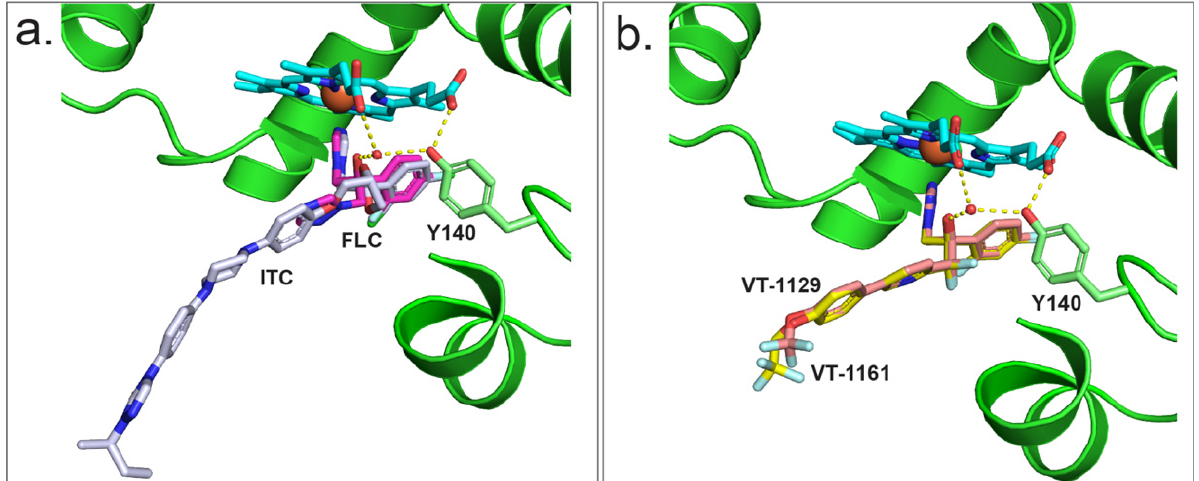
Figure 9. ( a ) Binding of FLC (PDB ID: 4WMZ) (magenta stick) and ITC (PDB ID: 5EQB) (grey stick) in the active site of ScCYP51. ( b ) Binding of VT-1161 (PDB ID: 5UL0) (yellow stick) and VT-1129 (PDB ID: 7RYX) (salmon stick) in the active site of ScCYP51. The ScCYP51 cartoon is green, and heme is depicted as cyan stick with the heme iron as orange sphere. Nitrogen atoms are blue and oxygen atoms are red. H-bond network involving the water molecules (small red sphere), the OH group of Y140 and the heme RCC and RCD are shown as yellow dashed lines.